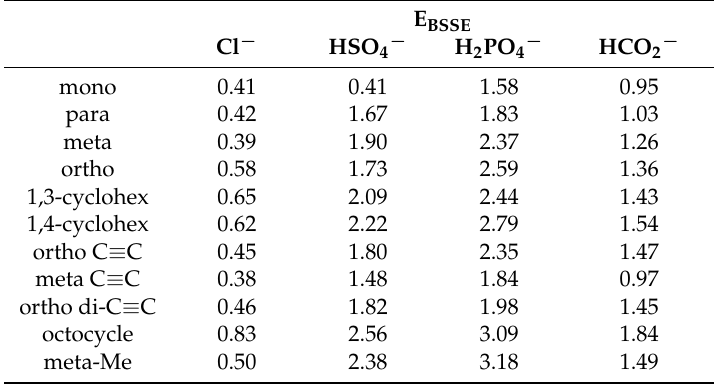
Table 2. Basis set superposition error (kcal/mol) as corrected by counterpoise procedure. 145